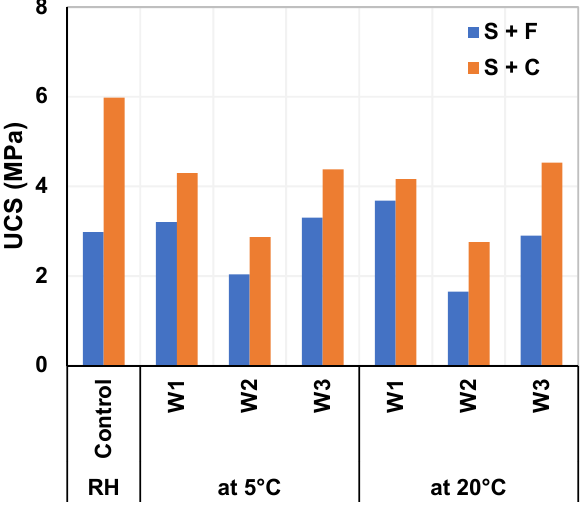
Figure 9. UCS at 360 days for soil stabilized with different binders, temperatures, and sulfate solutions.